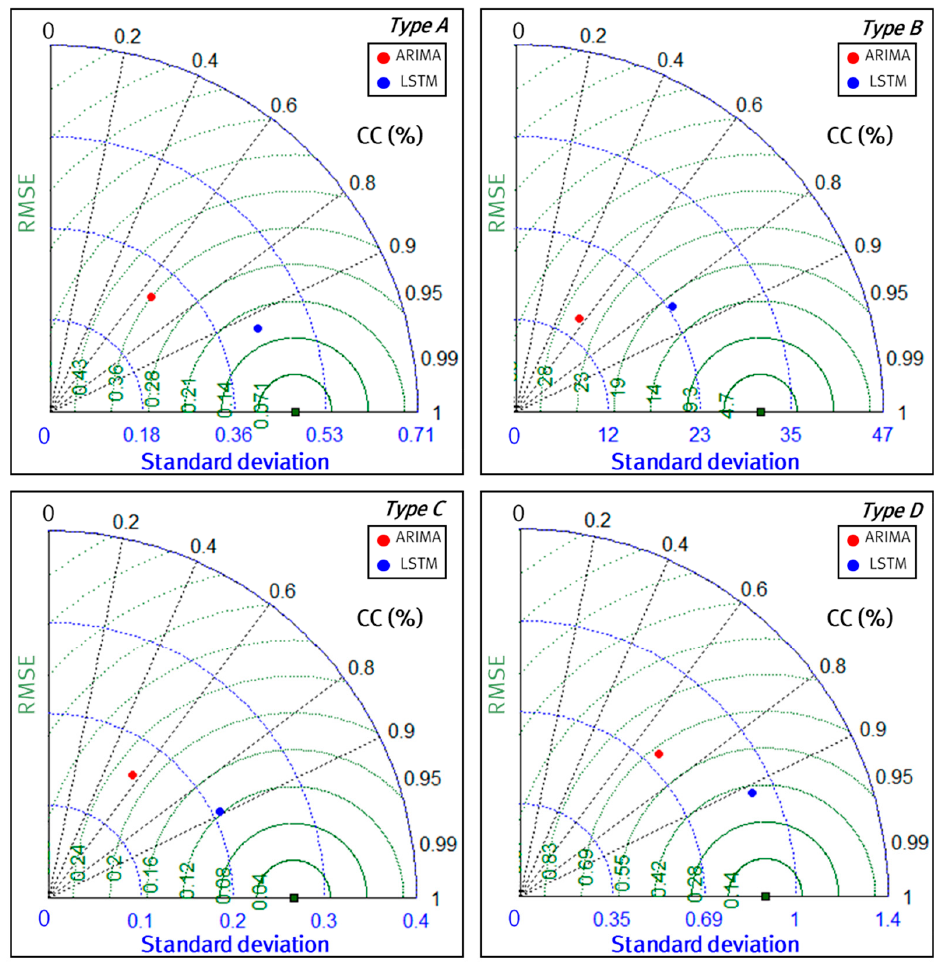
Figure 11. Taylor diagram for each